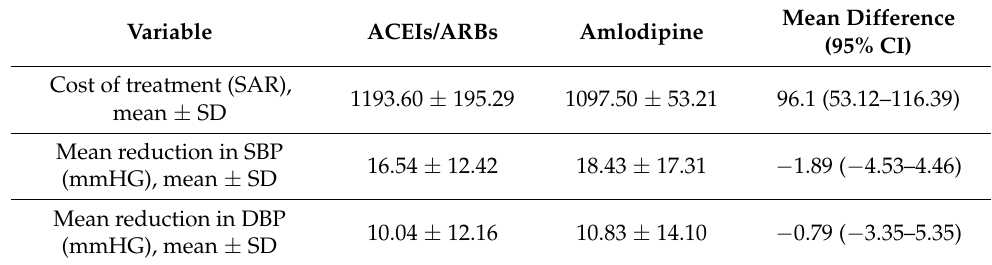
Figure 2. Box plot of baseline and follow-up SBP and DBP for patients on ACEIs/ARBs and amlodi- pine. The box represents the 25th and 75th percentiles, and the whiskers are the upper and lower adjacent values. The following shapes, , , , and represent the means of the baseline SBP, baseline DBP, follow-up SBP, and follow-up DBP, respectively. The outside written values are outliers.